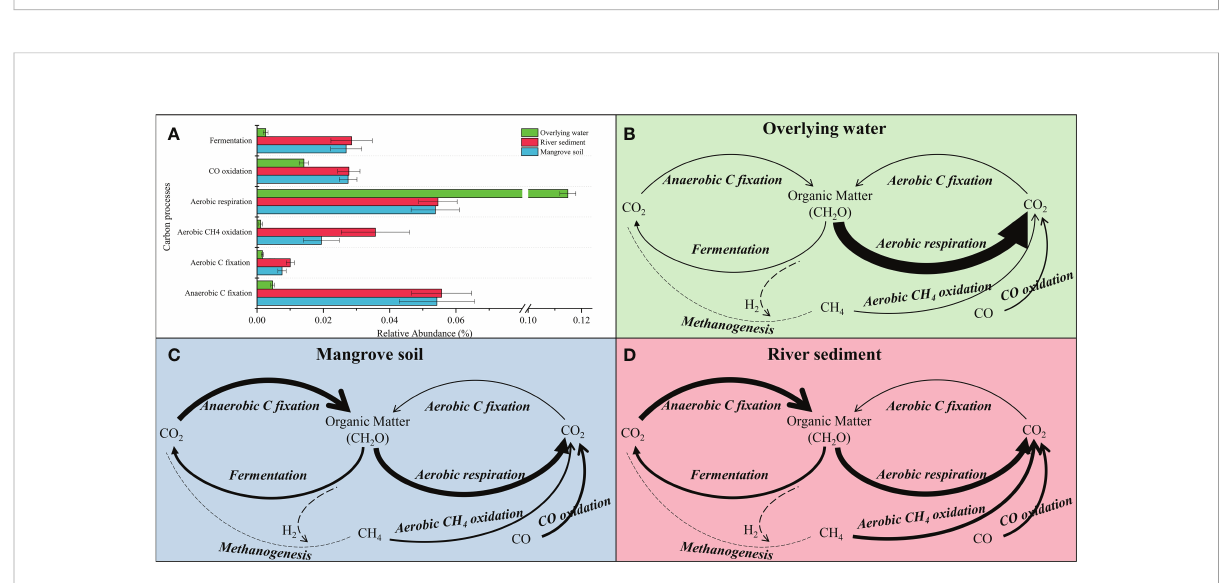
FIGURE 4 Relative abundance of genes response to carbon processes for bacterial communities (A) . The genetic potential for each conversion step in the carbon cycles in overlying water (B) , mangrove soil (C) and river sediment (D) microhabitats. The width of each arrow line is proportional to the relative abundance of the KEGG orthologies associated with the pathways. The dotted lines represent the conversion step without marker genes being